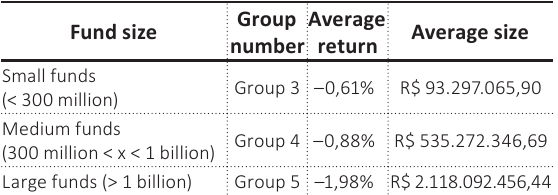
Table 4. Performance of FIPs selected by their size in